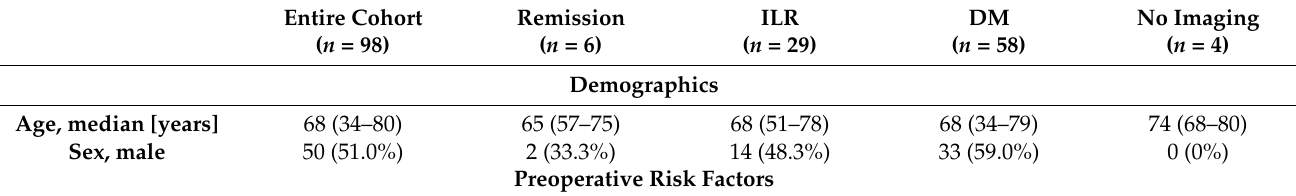
Table A1. Clinical parameters by site of first